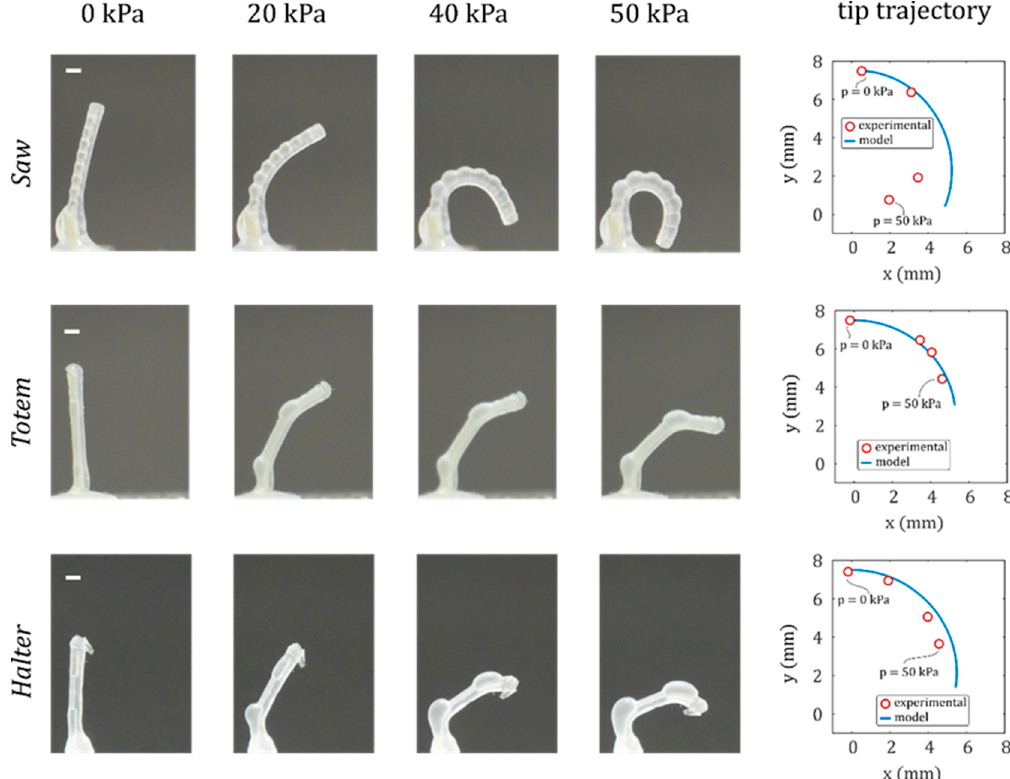
Figure 10. Microactuator inflation tests. Deformed configuration at four different pressures is reported for each microactuator. The white dash in the subfigures of the first column corresponds to a length of 0.8 mm. The experimental and modelled tip trajectory with respect to the initial position at 0 pressure is reported in the graphs.